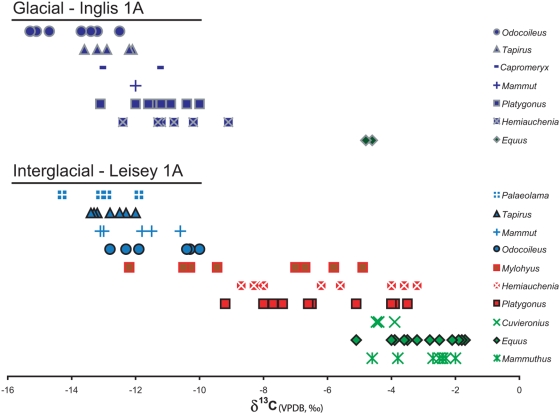
Carbon isotopic niche partitioning of all sampled taxa.Stable carbon isotope values for all taxa sampled at Inglis 1A (I) and Leisey 1A (L), with dominant C3 browsers (blue), mixed C3 and C4 consumers (red), and dominant C4 grazers (green) indicated.